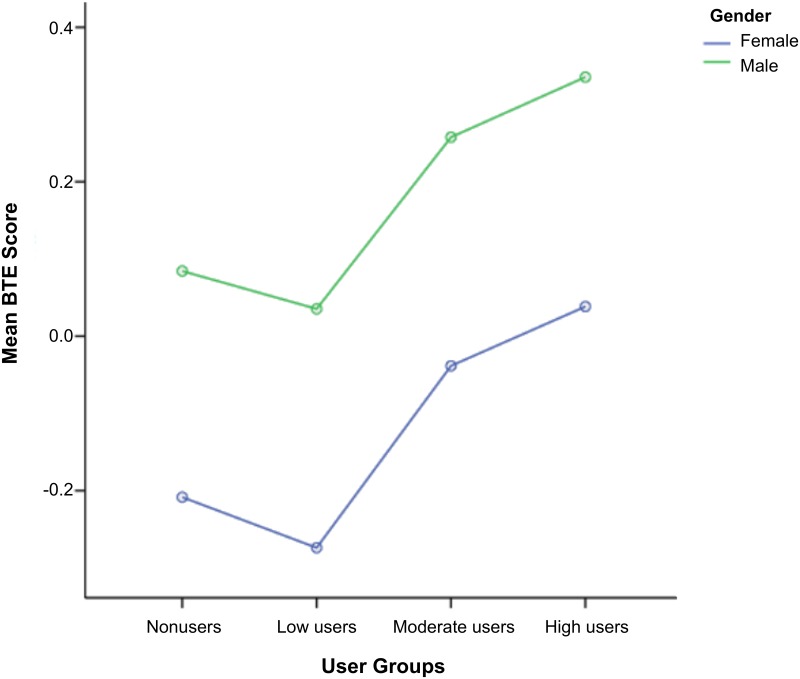
Students’ BTE performance as a function of gender and E2Coach usage across all user groups.